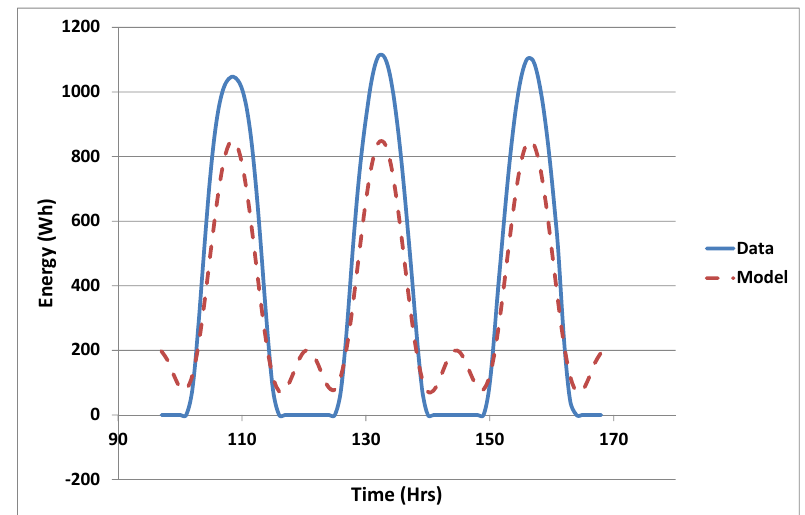
Figure 3. Effect of no sidebands on summer solar radiation.